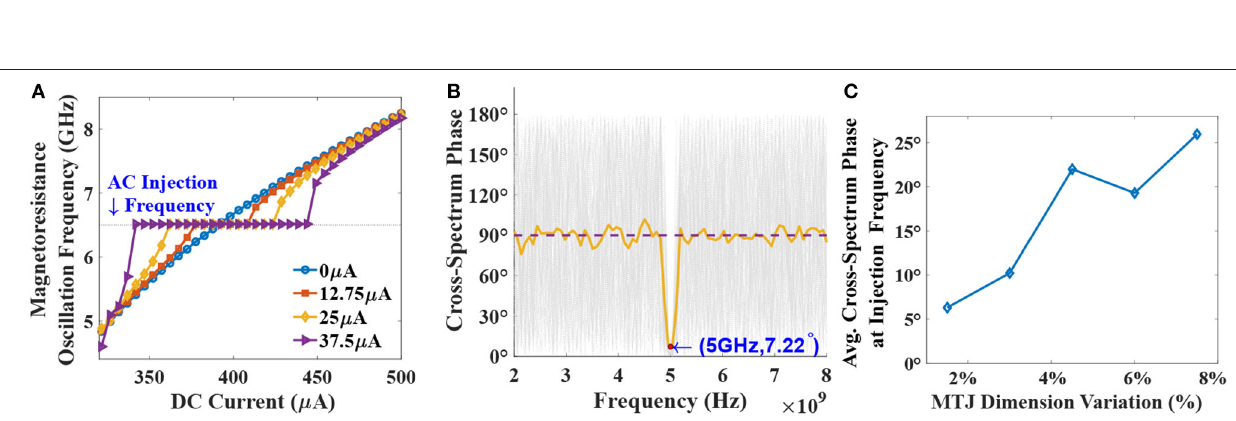
FIGURE 4 | (A) Oscillator frequency plotted against the DC current input to the device. Higher AC amplitudes lead to increased DC locking range at the injected RF signal of 6.5 GHz frequency. (B) Cross-spectrum phase for 100 independent stochastic LLGS simulations of two noisy MTJ neurons, under RF injection of 5 GHz . Average CPSD phase indicates tight phase-coupling at the required frequency with un-correlated activity at other frequencies. (C) Average cross-spectrum phase at the injection frequency accounting for device dimension